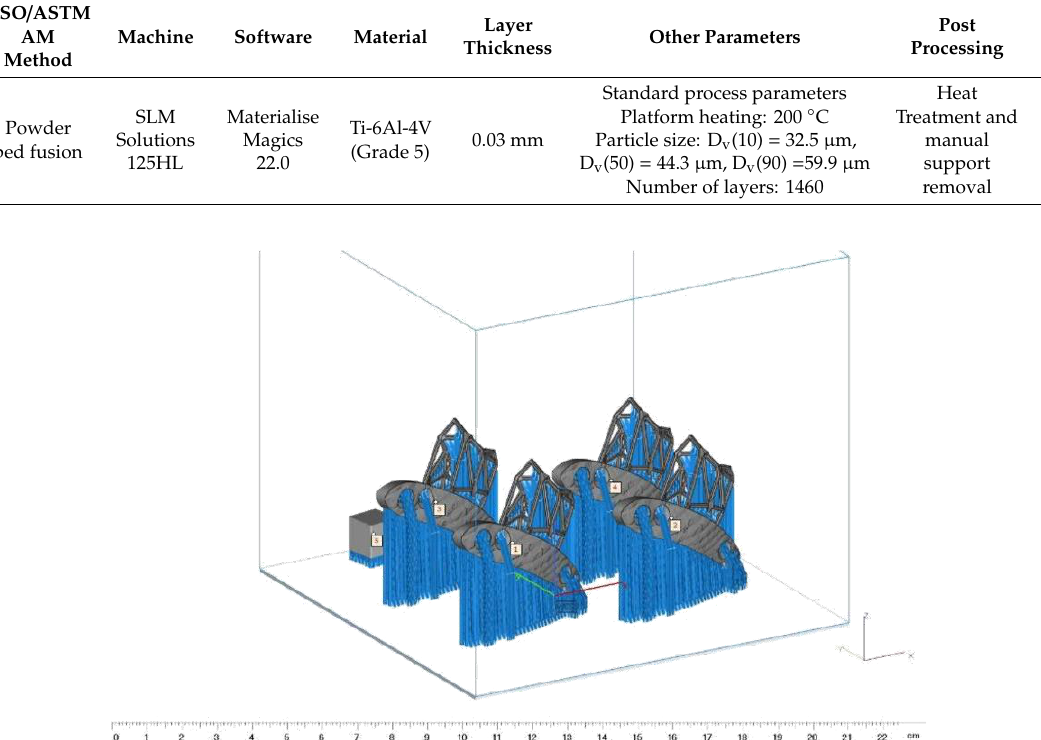
Figure 2. The print orientation and location of four identical implants on the build platform illustrating supports in blue.